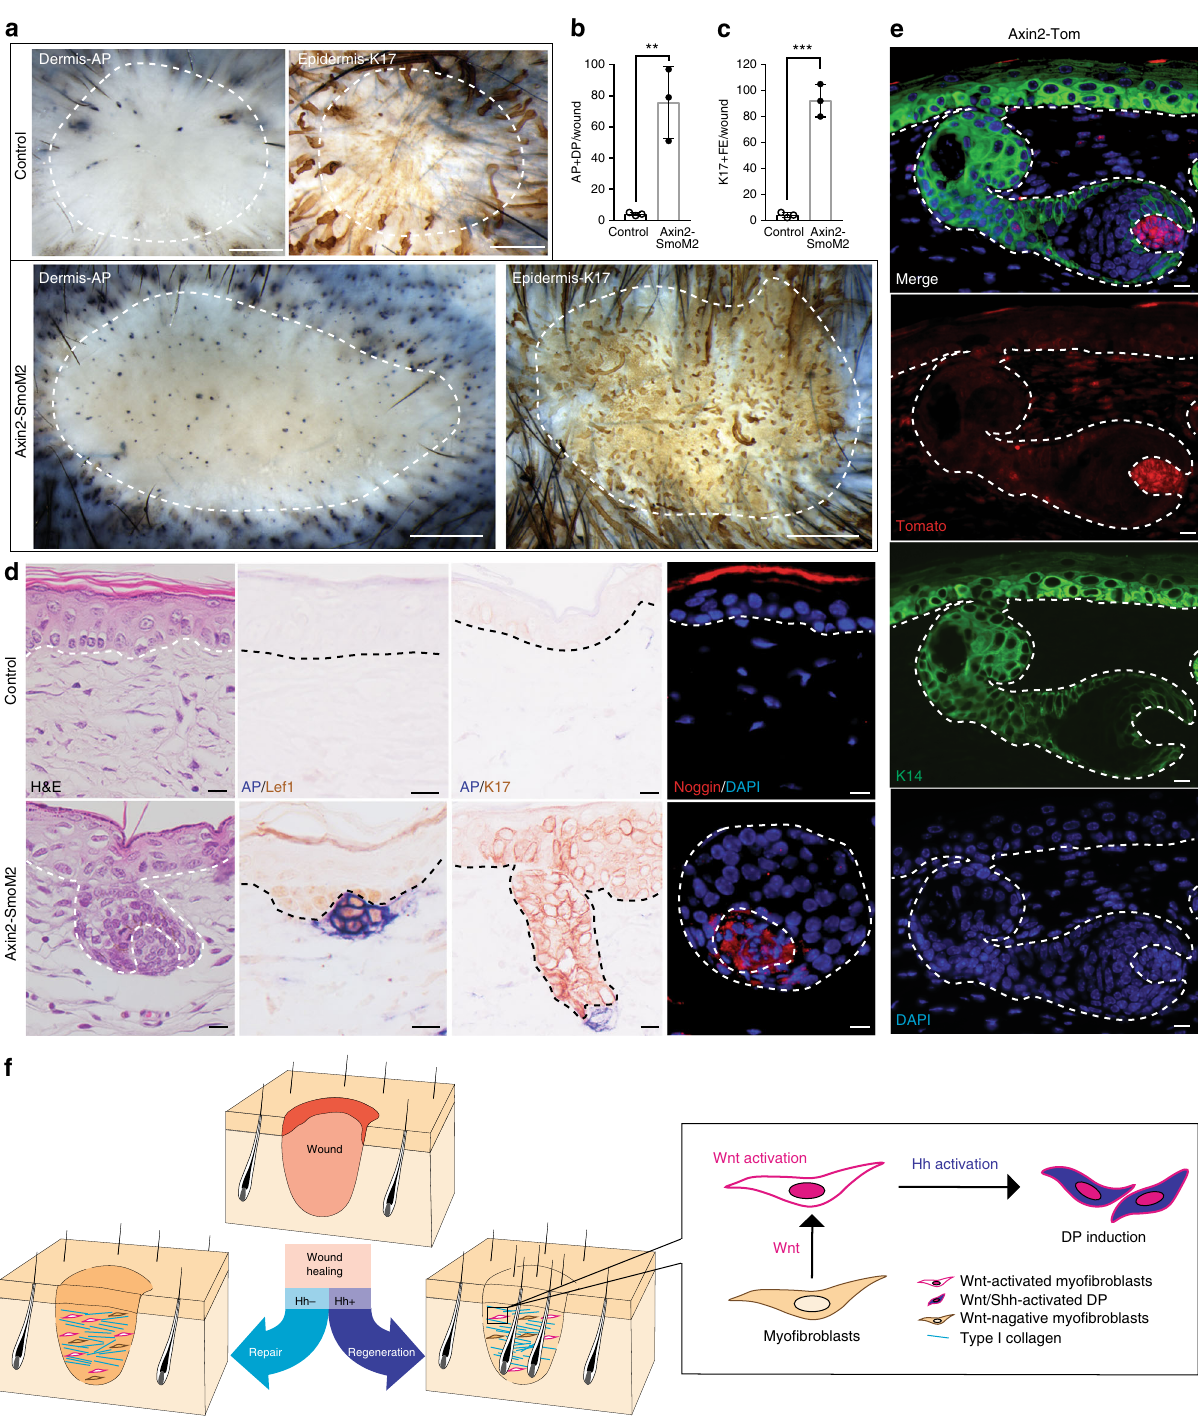
Fig. 6 Hh activation can convert fi brotic Wnt-active dermal cells into DP in wounds. a – d Axin2-CreER; R26-SmoM2 (Axin2-SmoM2) and littermate controls were subjected to SW and treated with TAM from PW1d until tissue harvest at PW30d ( n = 9 – 15 W (3 – 5 M) per condition). Whole-mount HFN assay ( a ) and quanti fi cations ( b , c ). H&E and immunohistochemical analyses with indicated markers ( d ). e Tracing of tomato-labeled Axin2 + cells in Axin2-CreER; R26- Tomato (Axin2-Tom). Axin2-Tom mice were subjected to LW and treated with TAM from PW3d until PW12d (before complete re-epithelialization). Tissue was harvested at PW23d and stained with anti-RFP antibody. f Model: Conversion of wound repair to regeneration in adult skin. Wound healing in mammalian skin typically results in scarring and lack of appendage regeneration. Dermal Hh activation can install de novo dermal papilla into wounds, resulting in regenerative HF neogenesis, despite collagen deposition in adult wounds. n : number of wounds (W) or mice (M), Data are represented as mean ±s.d., ** p < 0.01, *** p < 0.001; Student ’ s t -test, Dashed white circle: wound boundary, Dashed line: epidermis – dermis border, SW small wound, LW